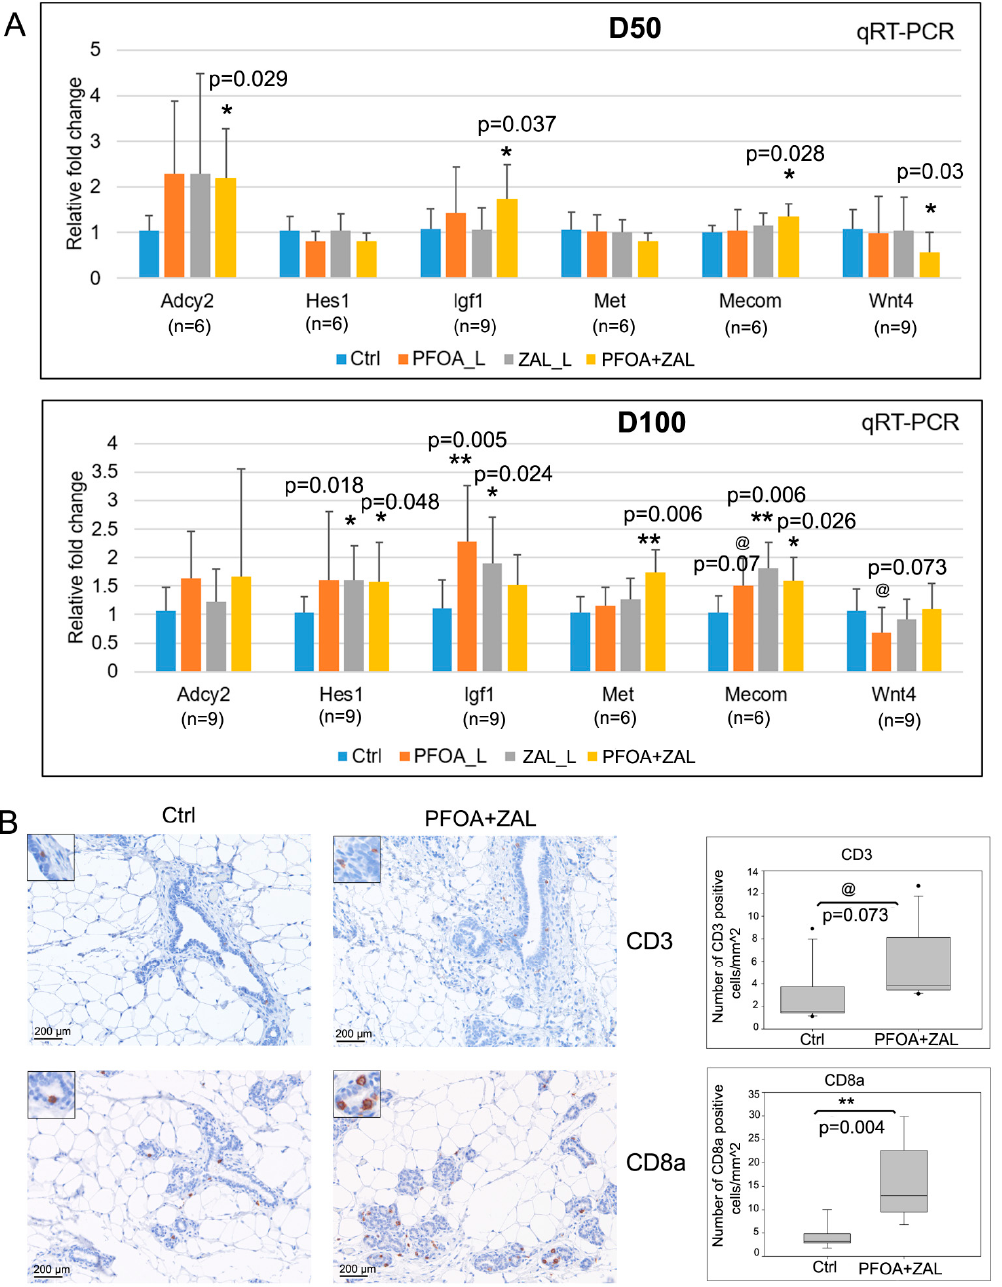
Figure 5. RT-PCR validation and IHC analysis for selected DEGs: ( A ) Graphs show qRT-PCR analysis of selected DEGs involved in mammary gland development or carcinogenesis. ( B ) IHC analysis of CD3 and CD8a in rat mammary glands. The Mann–Whitney rank sum test was used for statistical analysis. Sample size: n = 7. Magnification: 20 × objective. Scale bar: 200 µ m; * indicates p < 0.05, ** indicates p < 0.01, @ indicates p < 0.1 compared to